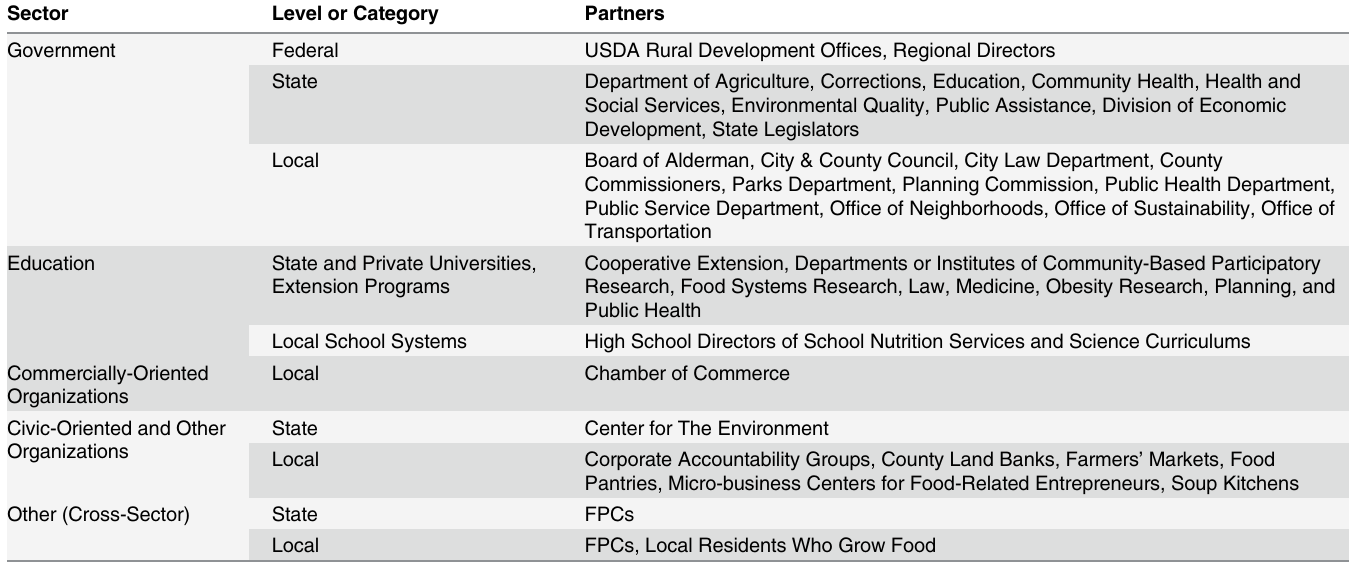
Table 3. FPC Partnership